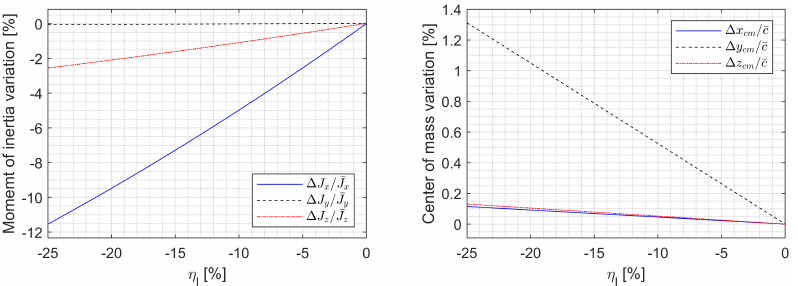
Figure 2. Parameter variation due to η l when η r =